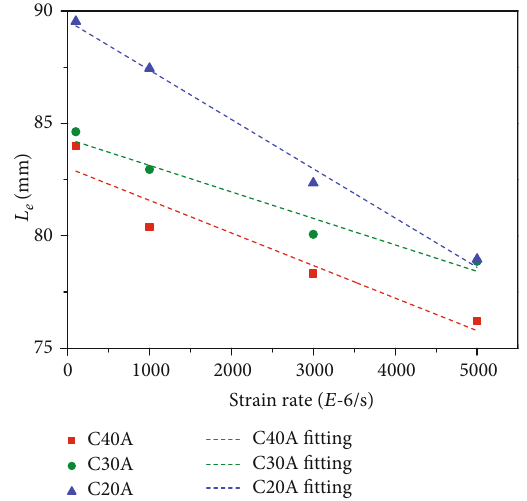
Figure 7: Strain rate e ff ect on the e ff ective bond length of